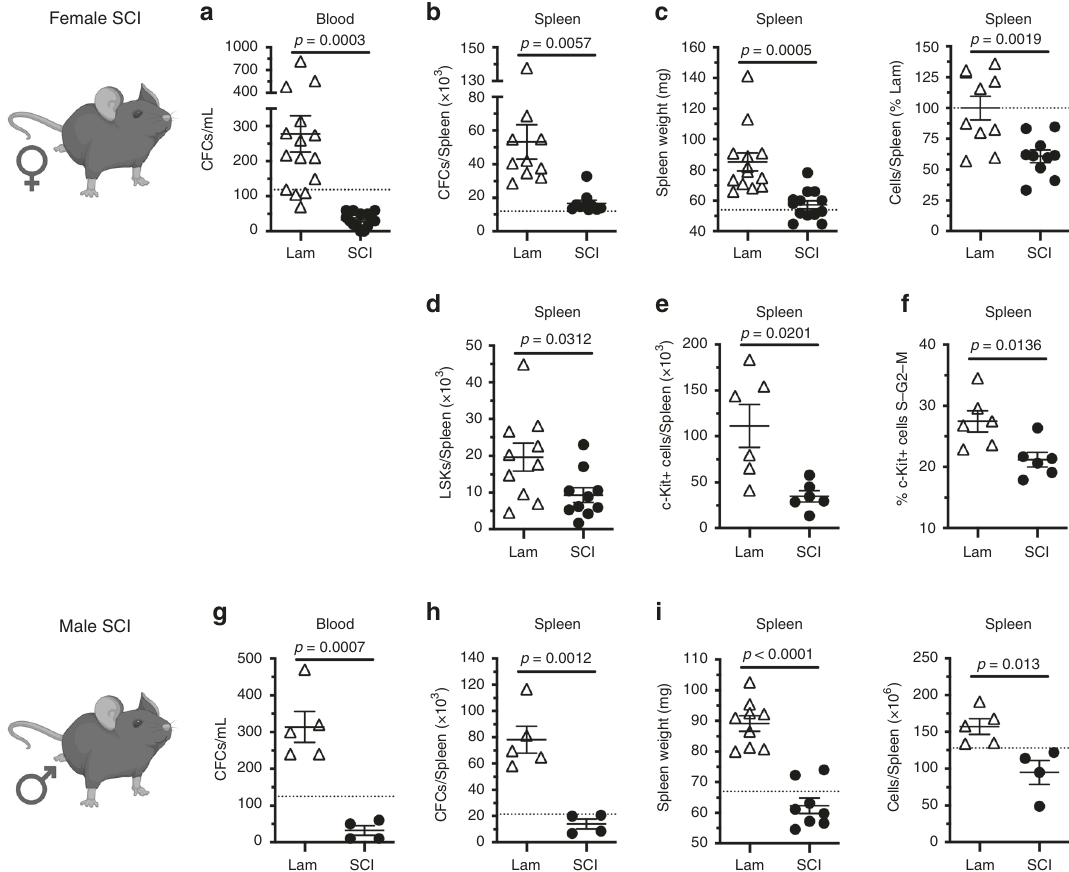
Fig. 3 T3 transection SCI prevents acute HSPC mobilization into blood and traf fi cking to the spleen at 3 dpi. a – f Outcomes in female mice at 3 dpi. a Total numbers of CFCs per mL of whole blood. b Total numbers of CFCs per spleen. c Spleen weight and number splenocytes (% of Lam). d , e Total numbers of ( d ) LSK and ( e ) c-Kit + cells in the spleen. f Proportion of proliferating c-Kit + cells (S – G2 – M phase) in the spleen. g – i Identical parameters as measured in a – c in male mice at 3 dpi. All data are mean ± SEM, two-sample t -test; n = 15/group in a ; n = 10/group in b – d (15/group spleen weight); n = 6/group in e , f ; n = 4 and 5/group g – i (8 and 9/group spleen weight). Dotted lines represent average data from naïve mice. dpi days post-injury,